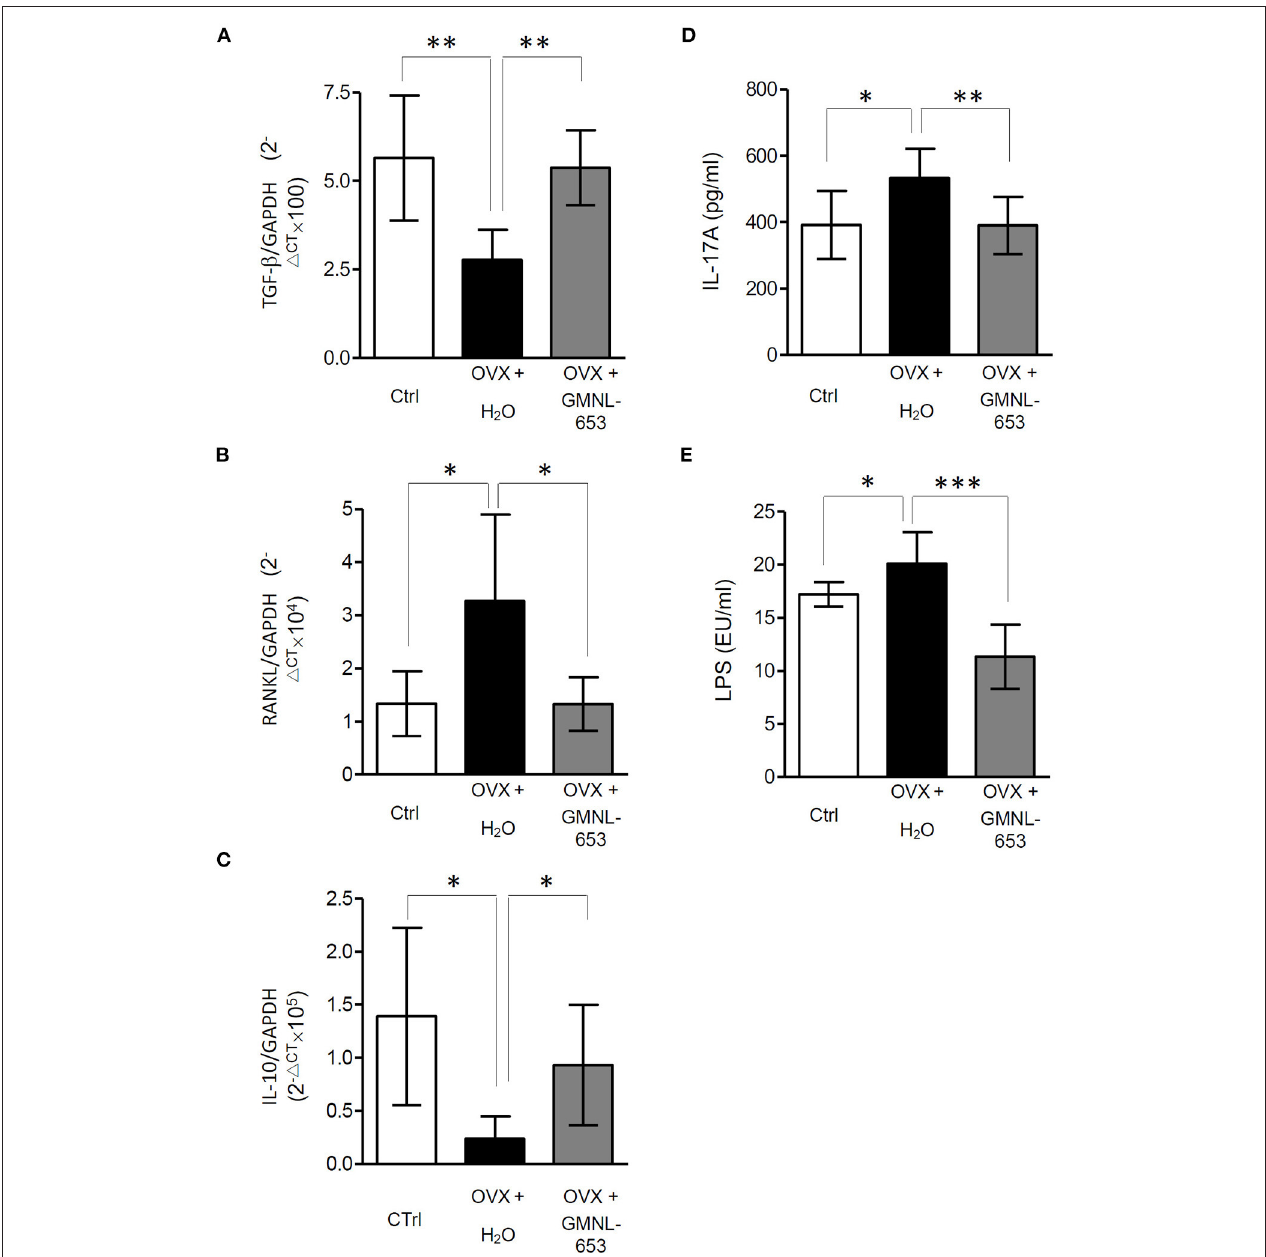
FIGURE 3 | (A–C) The mRNA levels of TGF- α , RANKL , and IL-10 in the tibia. (D,E) The IL-17A and LPS levels in the sera of ovariectomized (OVX) mice treated with either the vehicle (H 2 O) or heat-killed L. paracasei (GMNL-653). qRT-PCR analysis of the expression of genes known to promote bone formation, TGF- β and IL-10 (A,C) , and bone resorption, RANKL , in the tibia of OVX mice. The levels of IL-17A and LPS in the sera are measured through ELISA. * P < 0.05, ** P < 0.01, and *** P < 0.001 compared with the OVX + H 2 O group.